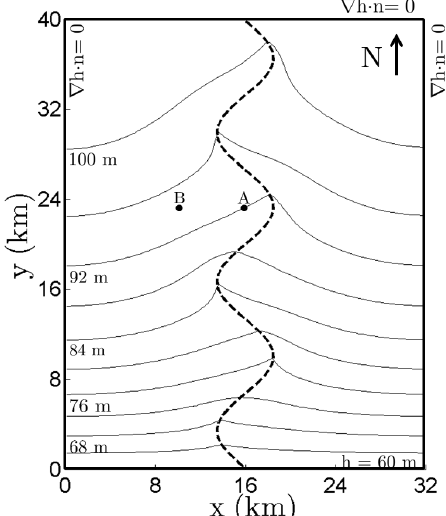
Figure 2. Plan view of steady state head distribution in the modeled aquifer with K = 5 m d − 1 and a homogeneous K = 0 . 003 m d − 1 . Pumping is not considered in this r scenario; however, pumping well locations are represented at points A ( x, y ) = (15.875 km, 23.175 km) and B ( x, y ) = (9.875 km, 23.175 km). The boundary conditions are shown on the model boundaries and the stream is represented by a dashed line.